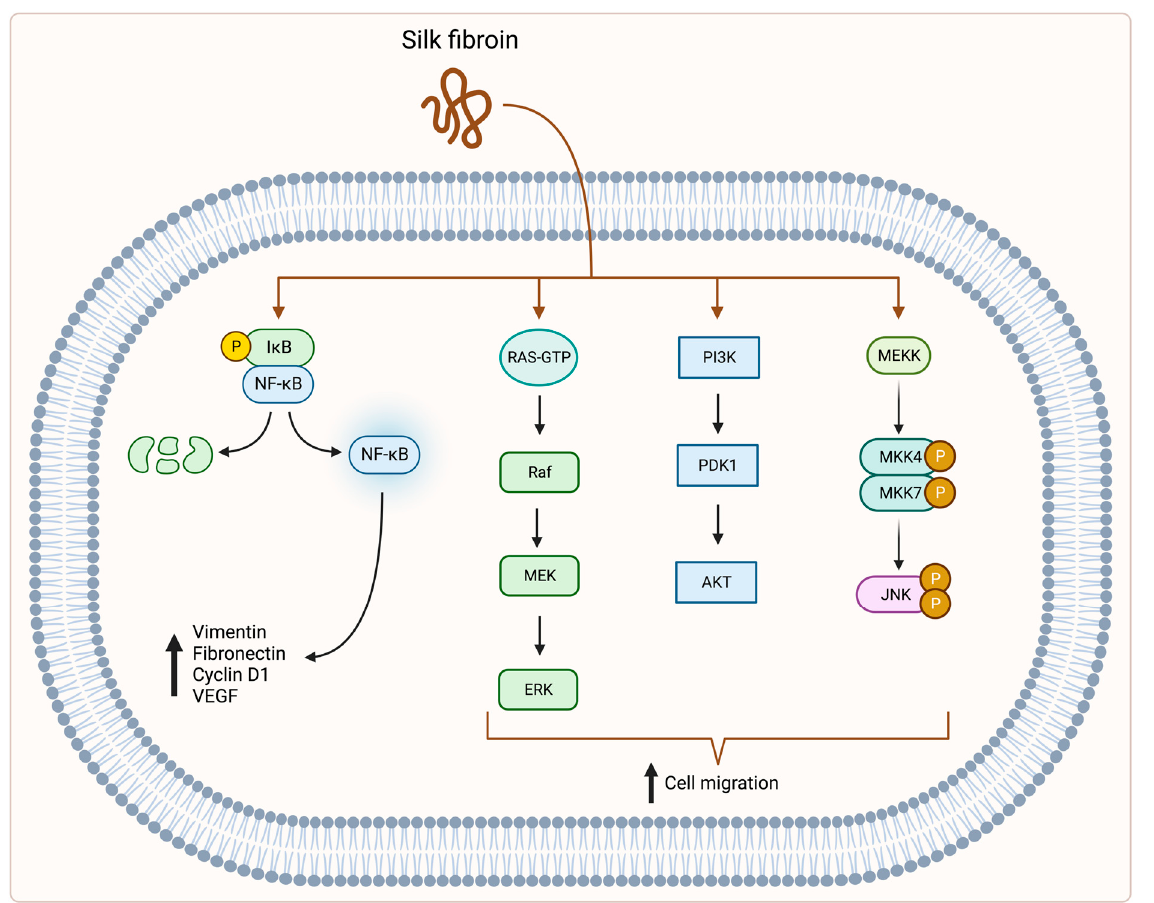
Figure 2. SF stimulates the expression of NF-kB signalling pathway genes, which leads to higher expression of vimentin, fibronectin, cyclin D1, and VEGF [72]. SF also stimulates MEK, PI3K, and JNK pathways, which leads to increased cell migration [77]. Abbreviations: I κ B—inhibitor